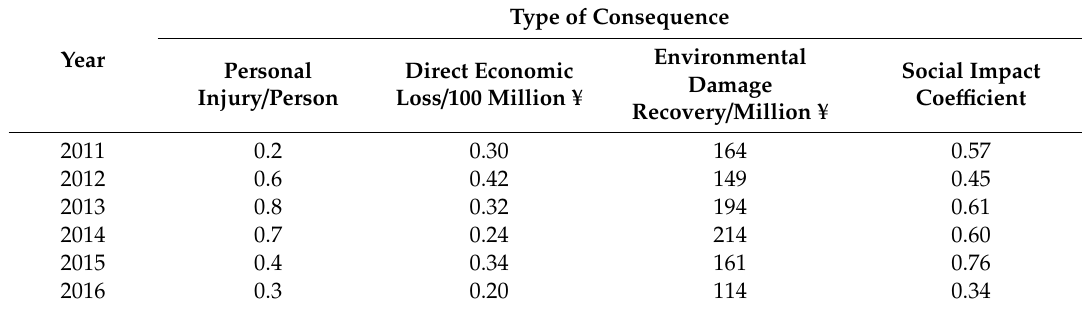
Table 10. Data on the types of leakage consequences of heavy oil gathering pipelines in the A oilfield. Year Personal Injury / Person